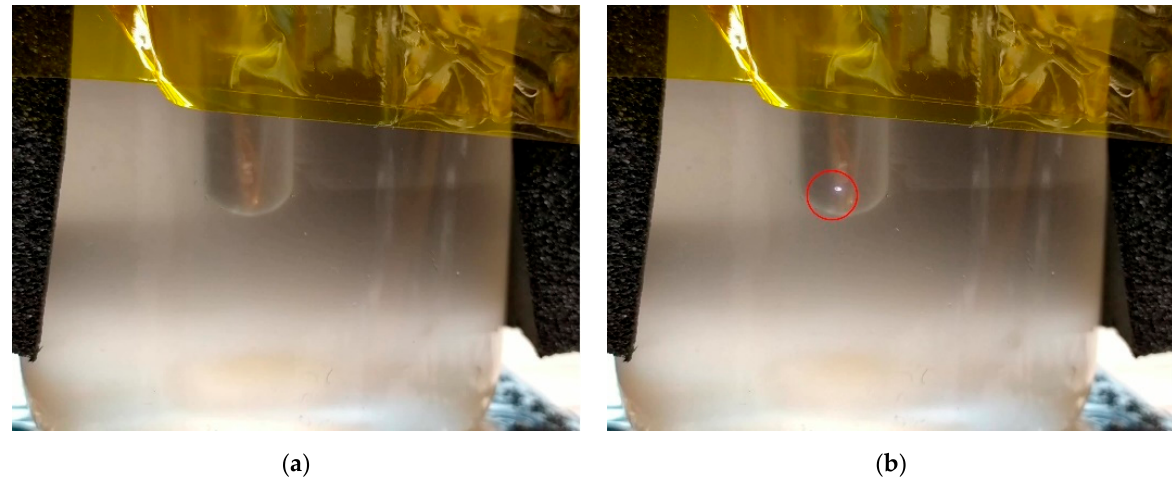
Figure 11. Pictures taken during the experiments at high voltage and short time of exposure: ( a ) before an electric pulse; ( b ) generation of an electrical arc (center of the red circle).